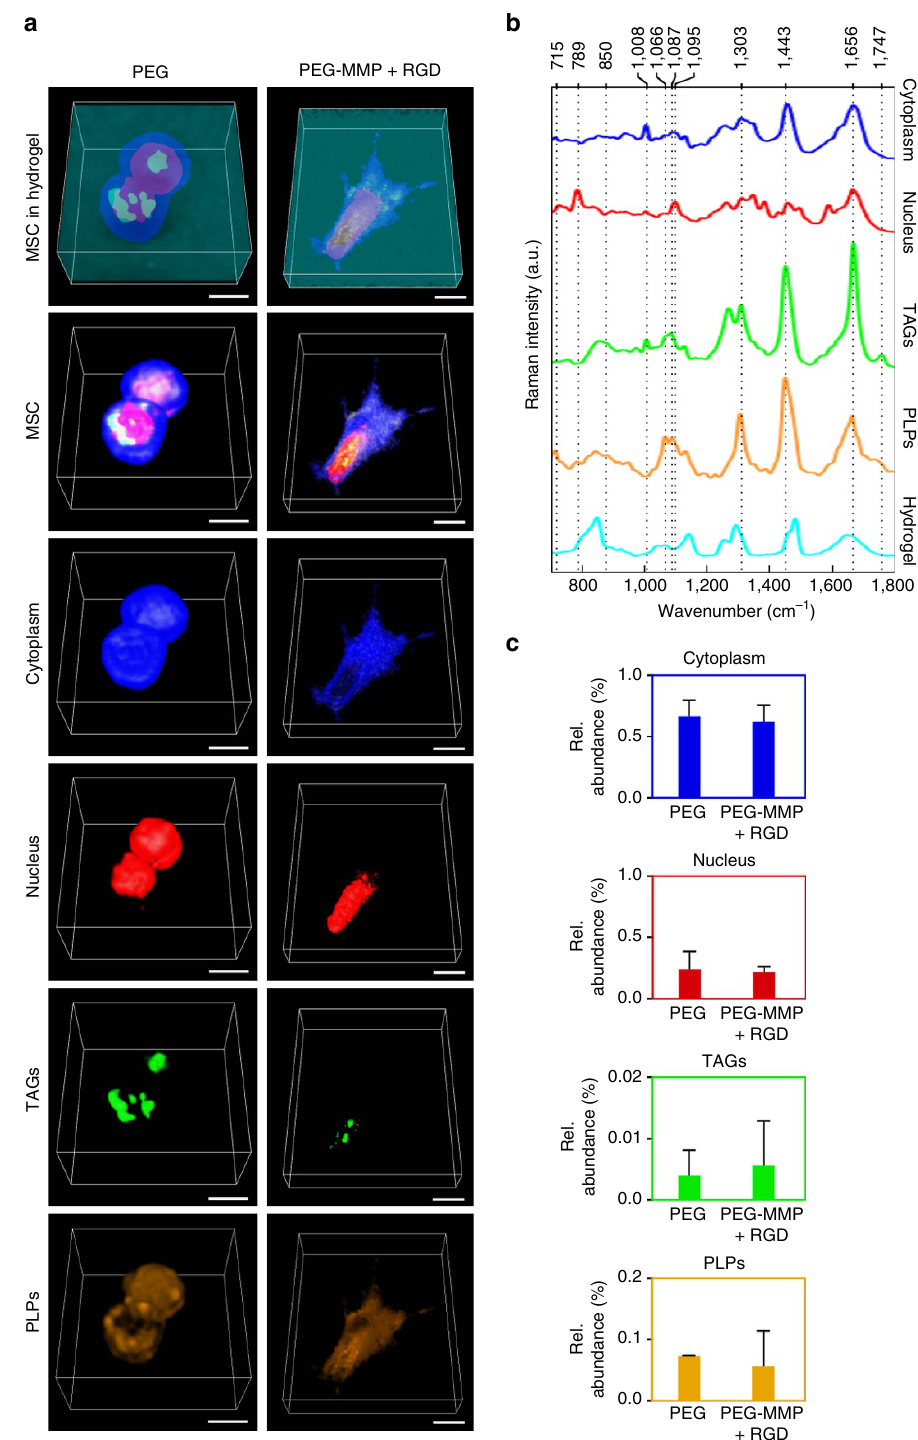
Figure 4 | Volumetric quantification of cellular biochemical components in a 3D culture system. Representative 3D reconstructions by qVRI, of the main subcellular components of hMSCs ( n ¼ 2 cells per hydrogel) in ( a ) a bioactive (PEG-MMP þ RGD) and a bioinert (PEG) hydrogel, and their corresponding ( b ) endmember Raman spectra from VCA (showing five components); from top to bottom cytoplasm (blue), nucleus (red), triacylglycerols (green), phospholipids (orange) and hydrogel (cyan). ( c ) Bar chart of mean abundance values for each subcellular component. Error bars represent one standard deviation around the mean. Scale bar, 10 m